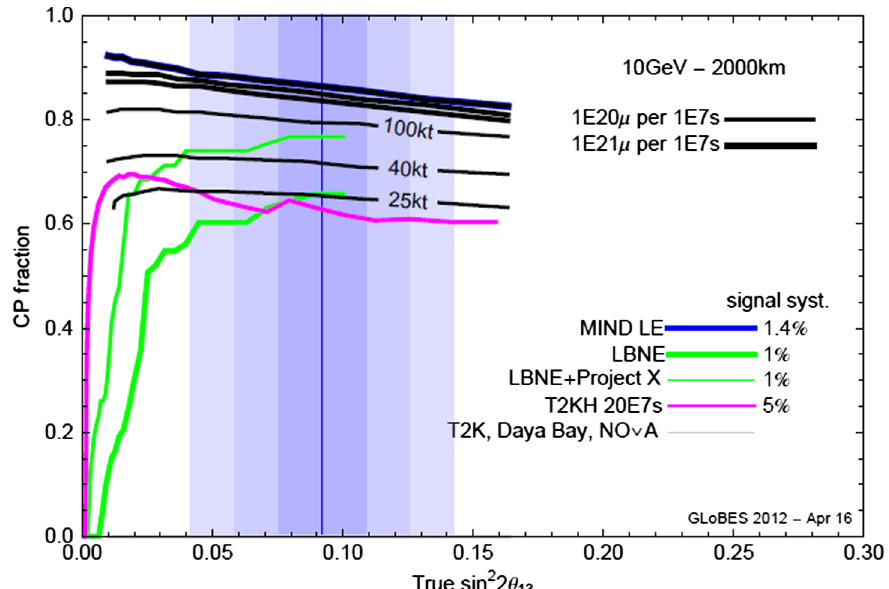
FIG. 28. A study of possible staging scenarios for a Neutrino Factory. The plot shows the fraction of the CP angle for which a measurement can be made for various MIND detector masses and the number of neutrinos produced per year. The current measured value of (cid:3) 13 is shown as a vertical line. The potential of the Neutrino Factory is compared to other possible future facilities in the U.S. (LBNE) and Japan (T2KH). The plot shows that a Neutrino Factory with a factor of 10 smaller neutrino flux than the full 4 MW version and a 25 kt MIND is already